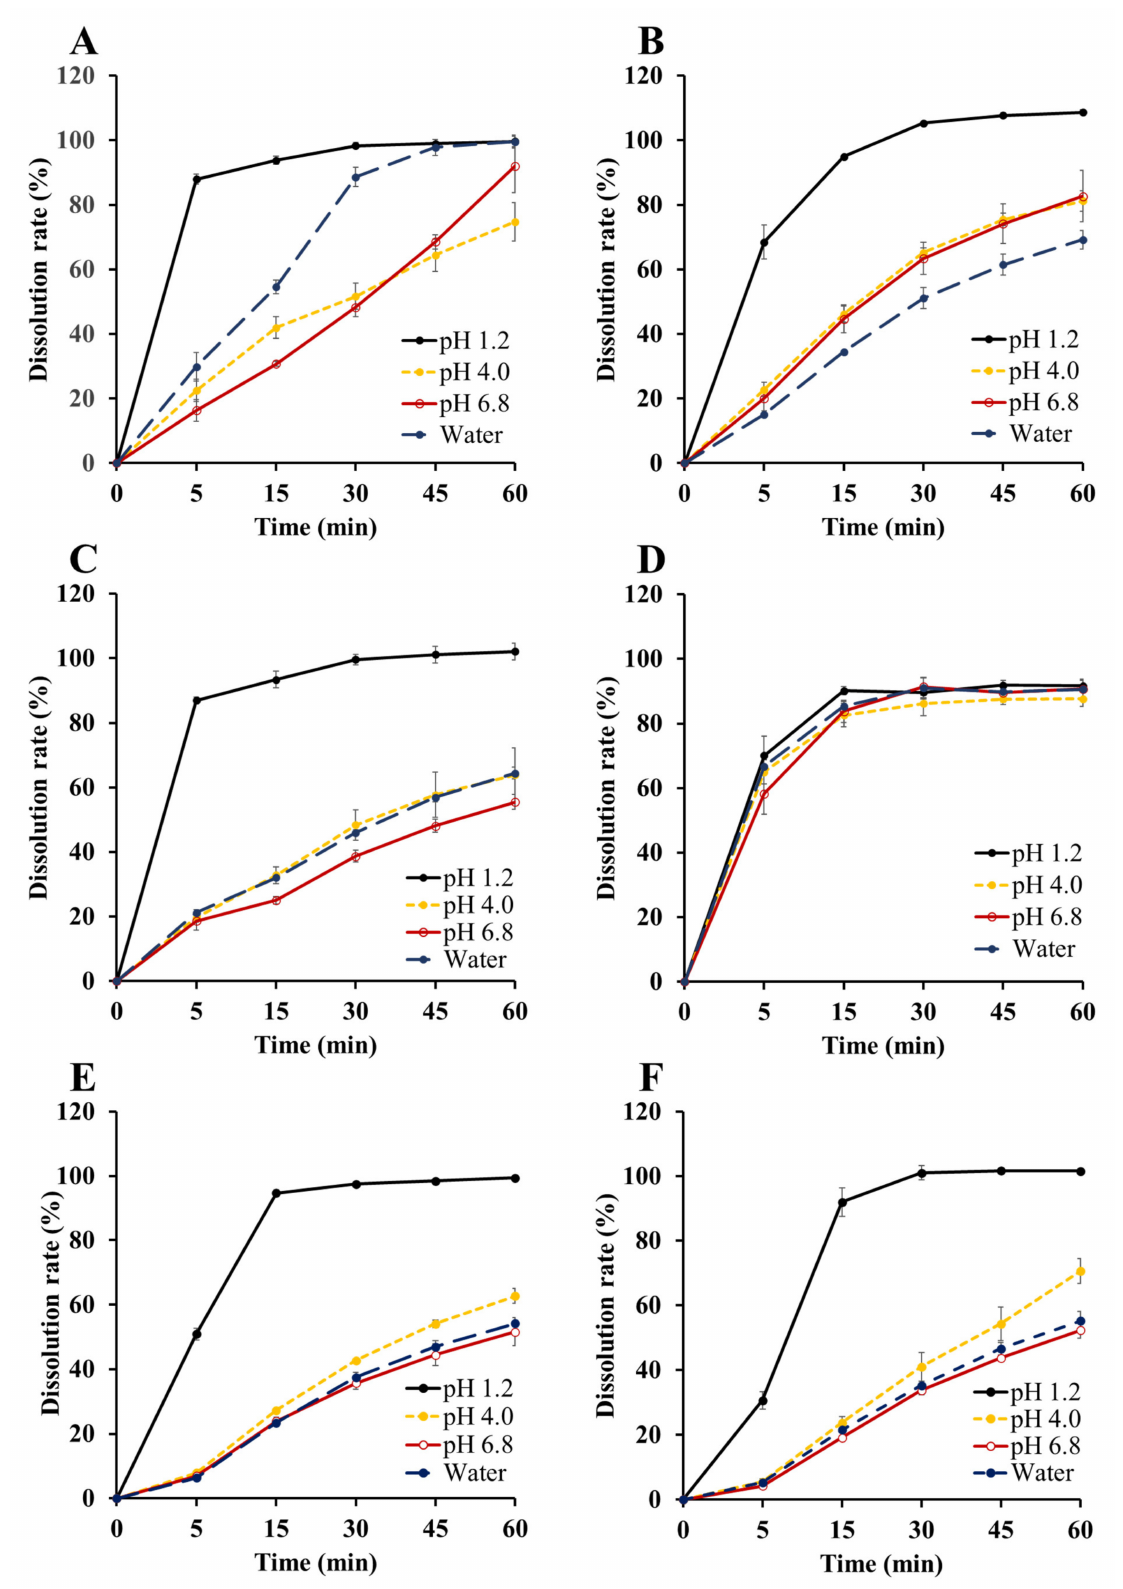
Figure 7. In vitro dissolution of JIN-001 formulations ( n = 3). ( A ) JIN-001 + Capryoil 90 capsule (F1); ( B ) JIN-001 tablet with SLS (F2); ( C ) JIN-001 tablet without solubilizer (F3); ( D ) JLS tablet (F4); ( E ) JIN-001 tablet with Gelucire (F5); ( F ) JIN-001 tablet with Poloxamer